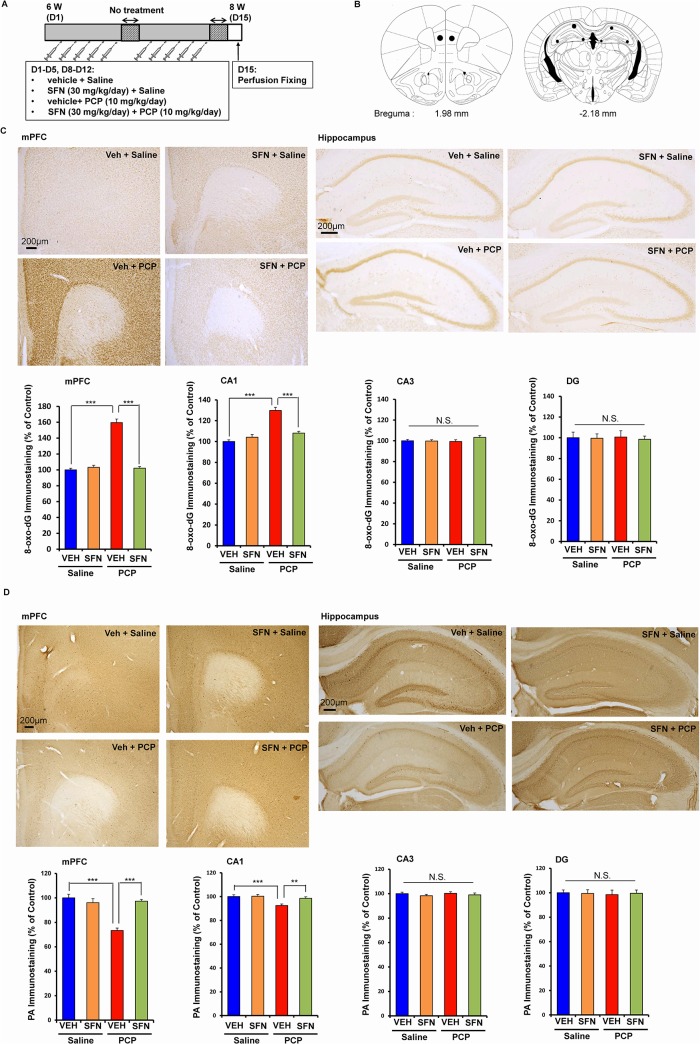
Prophylactic effect of SFN on PCP-induced alterations in 8-oxo-dG immunostaining and PV-positive immunostaining in the brain.(A): Treatment schedule and immunohistochemistry. On day 15, all mice were perfused. Then immunohistochemistry was performed. (B): Brain regions of medial prefrontal cortex (mPFC), CA1, CA3, and dentate gyrus (DG) of hippocampus, were shown. (C): Repeated PCP administration significantly increased 8-oxo-dG immunostaining in the mPFC and CA1, but not CA3 and DG. Pretreatment with SFN significantly attenuated PCP-induced increases of 8-oxo-dG immunostaining in the mPFC and CA1. The data show the mean ± SEM (n = 6 or 7). (C): Repeated PCP administration significantly decreased PV-positive immunostaining in the mPFC and CA1, but not CA3 and DG. Pretreatment with SFN significantly attenuated PCP-induced decreases of PV-positive immunostaining in the mPFC and CA1. The data show the mean ± SEM (n = 6 or 7). **P < 0.01, ***P < 0.001, N.S. not significant.